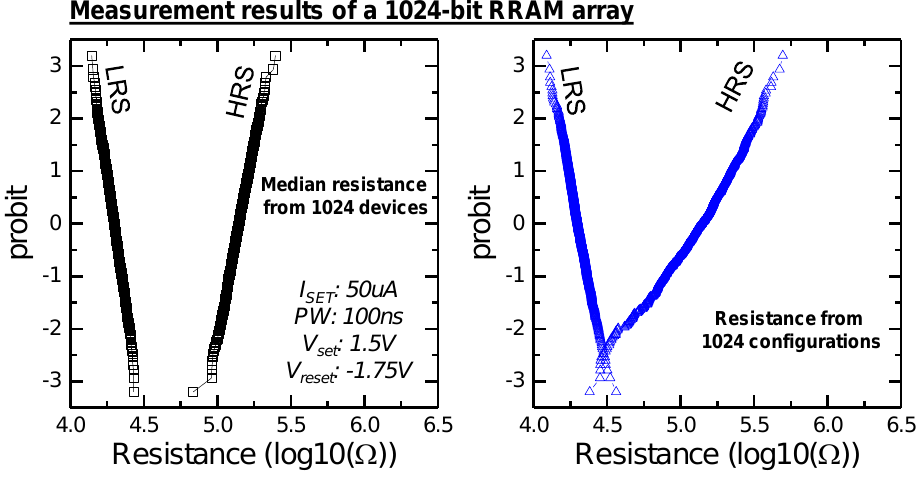
Figure 10: The median resistance distribution from 1024 RRAM devices and the resistance distribution from 1024 randomly selected configurations.